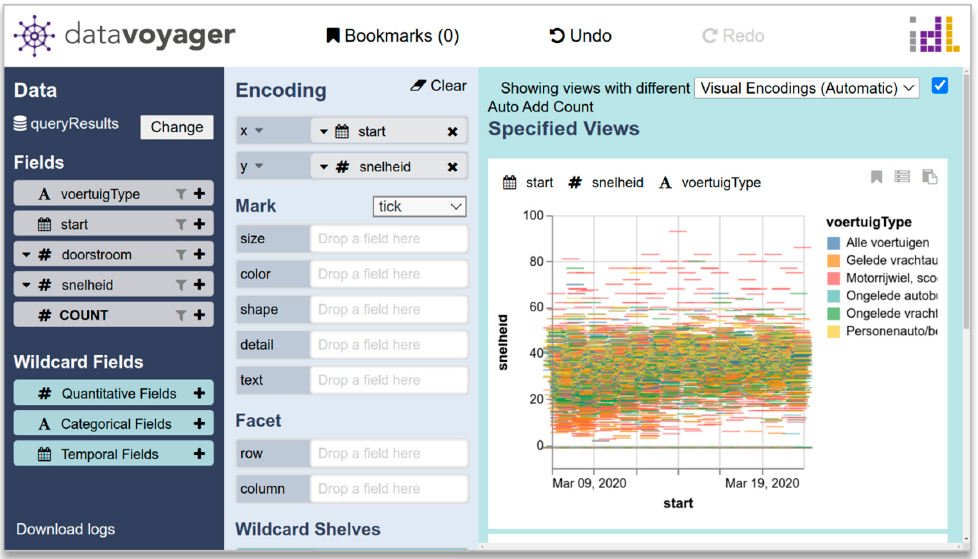
Figure 5. Demonstration of the Use of Linked Data selection within a Business Intelligence (BI) tool, Voyager. Retrieved from: https://labs.kadaster.nl/assets/videos/voyager.webm.